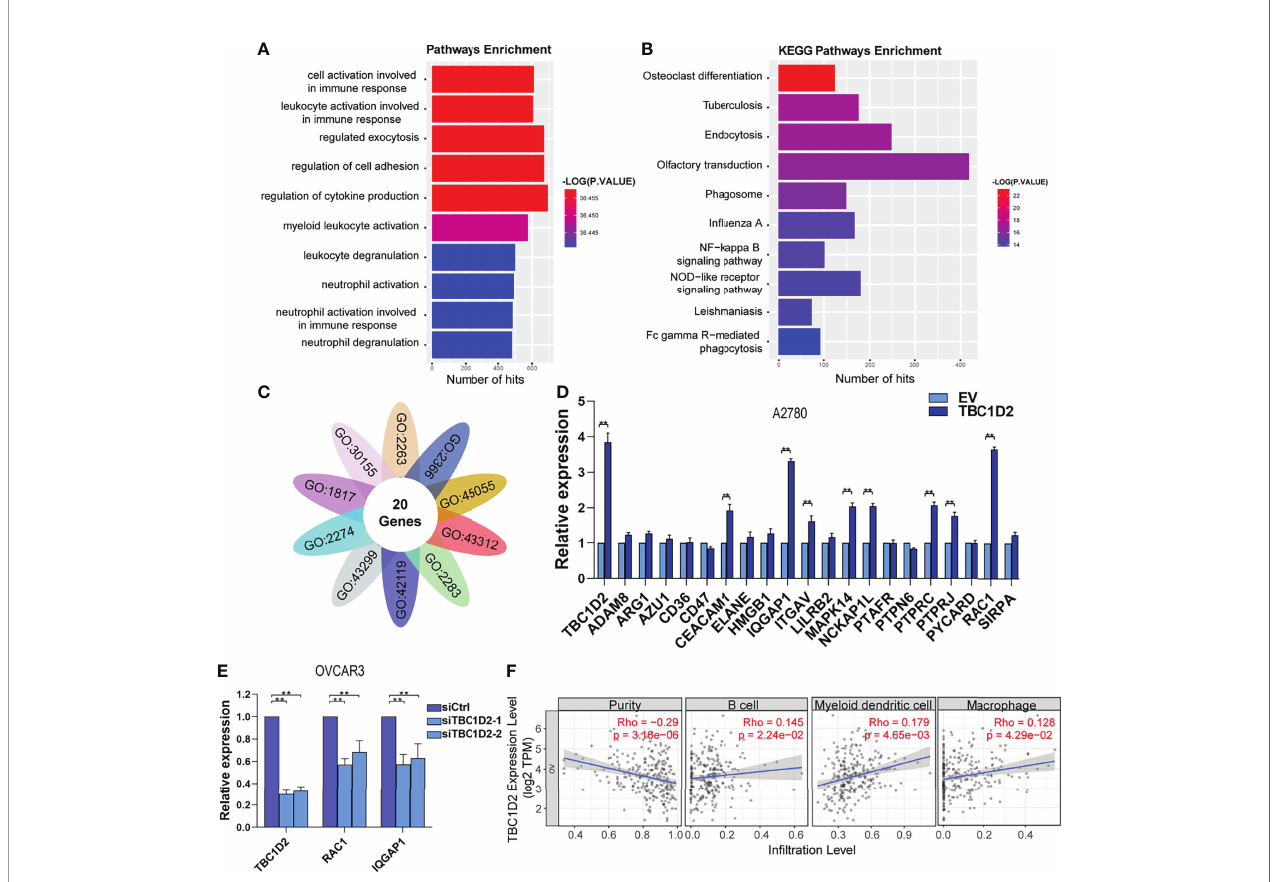
FIGURE 4 | TBC1D2 promotes ovarian cancer progression by upregulating RAC1 and IQGAP1 expression. (A, B) GO analysis and KEGG pathway analysis based on the Genetrail3.0 website. (C) Venn diagram of 20 overlapping genes based on the signi fi cant biological processes shown in Figure 4A . (D) qRT-PCR analysis of 20 overlapping genes in A2780 cells treated as indicated. (E) qRT-PCR analysis of TBC1D2, RAC1 and IQGAP1 in OVCAR3 cells treated as indicated. (F) Correlation analysis between TBC1D2 expression and immune cell in fi ltration in OC. Two-tailed Student ’ s t tests were used to determine the signi fi cance of differences between two groups; data are represented as mean ± SEM.